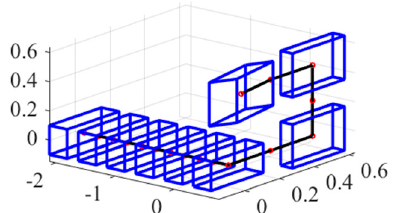
Figure 17. Initial configuration of SMSRS in case 2.